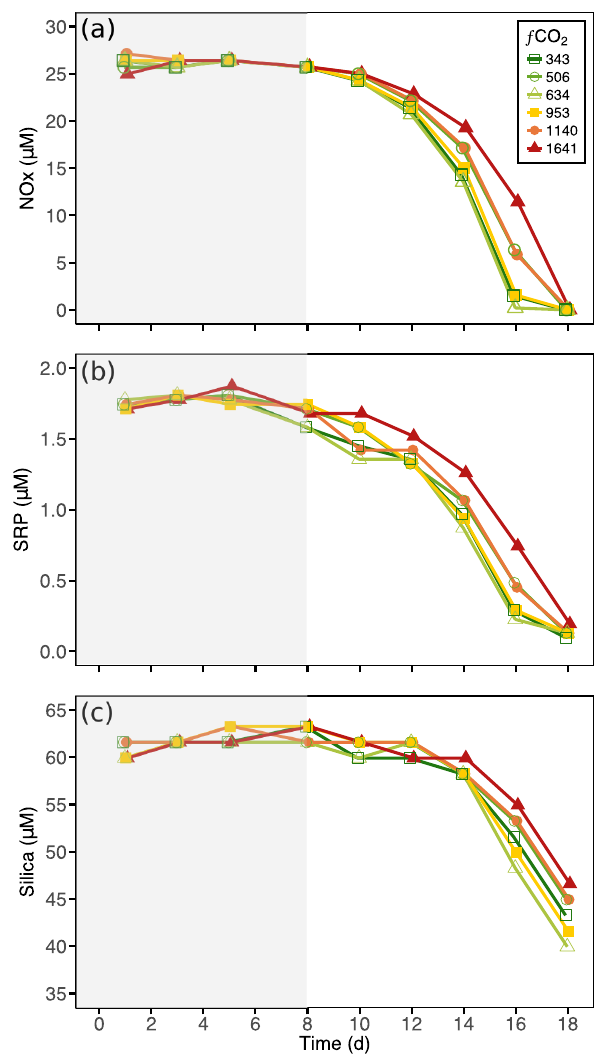
Figure 3. Nutrient concentration in each of the minicosm treatments over time. (a) Nitrate + nitrite (NO x ), (b) soluble reactive phospho- rus (SRP), and (c) molybdate reactive silica (silica). Grey shading indicates CO 2 and light acclimation